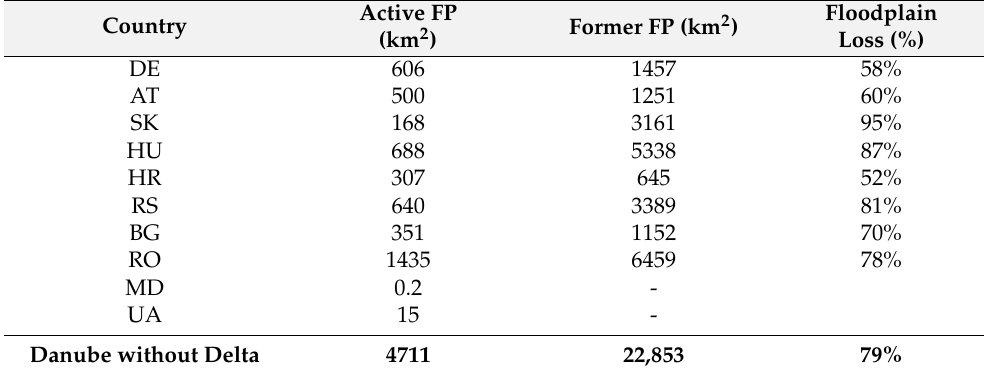
Table 4. Comparison between active and former floodplain area for each country (incl. main river channel and excl. Delta). Active Country